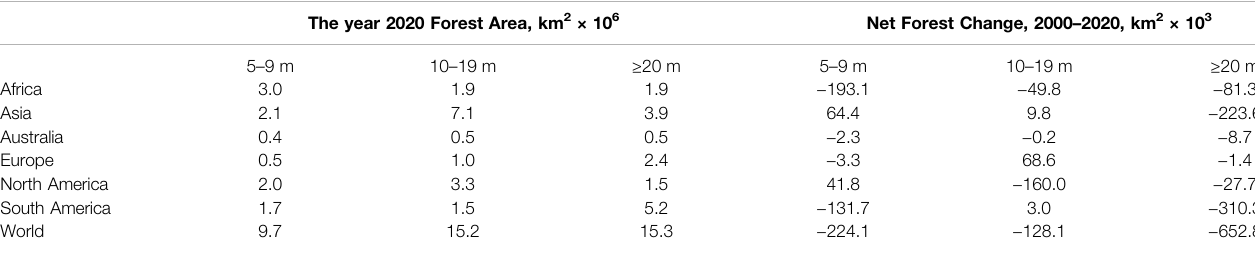
TABLE 2 | Map-based forest area and change, 2000 – 2020, by forest height strata.